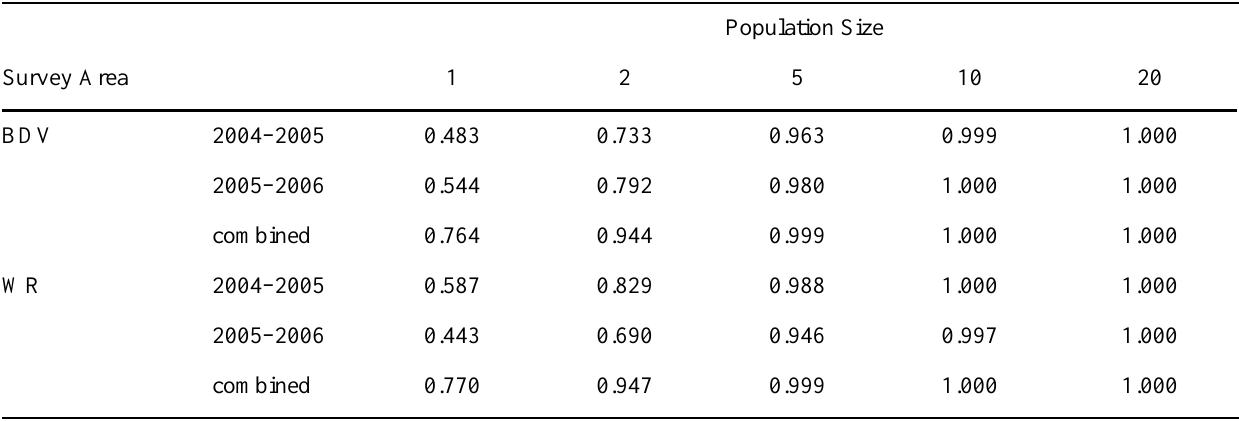
Table 3. Probabilities of sighting at least one Ivory-billed Woodpecker for populations of different sizes, given areas surveyed in 2004–2005 and 2005–2006 in an estimated 19 700-ha tract along White River (WR) and a 9500-ha tract at Bayou de View (BDV). Also included are joint probabilities of detection in at least 1 year, assuming independent probabilities between